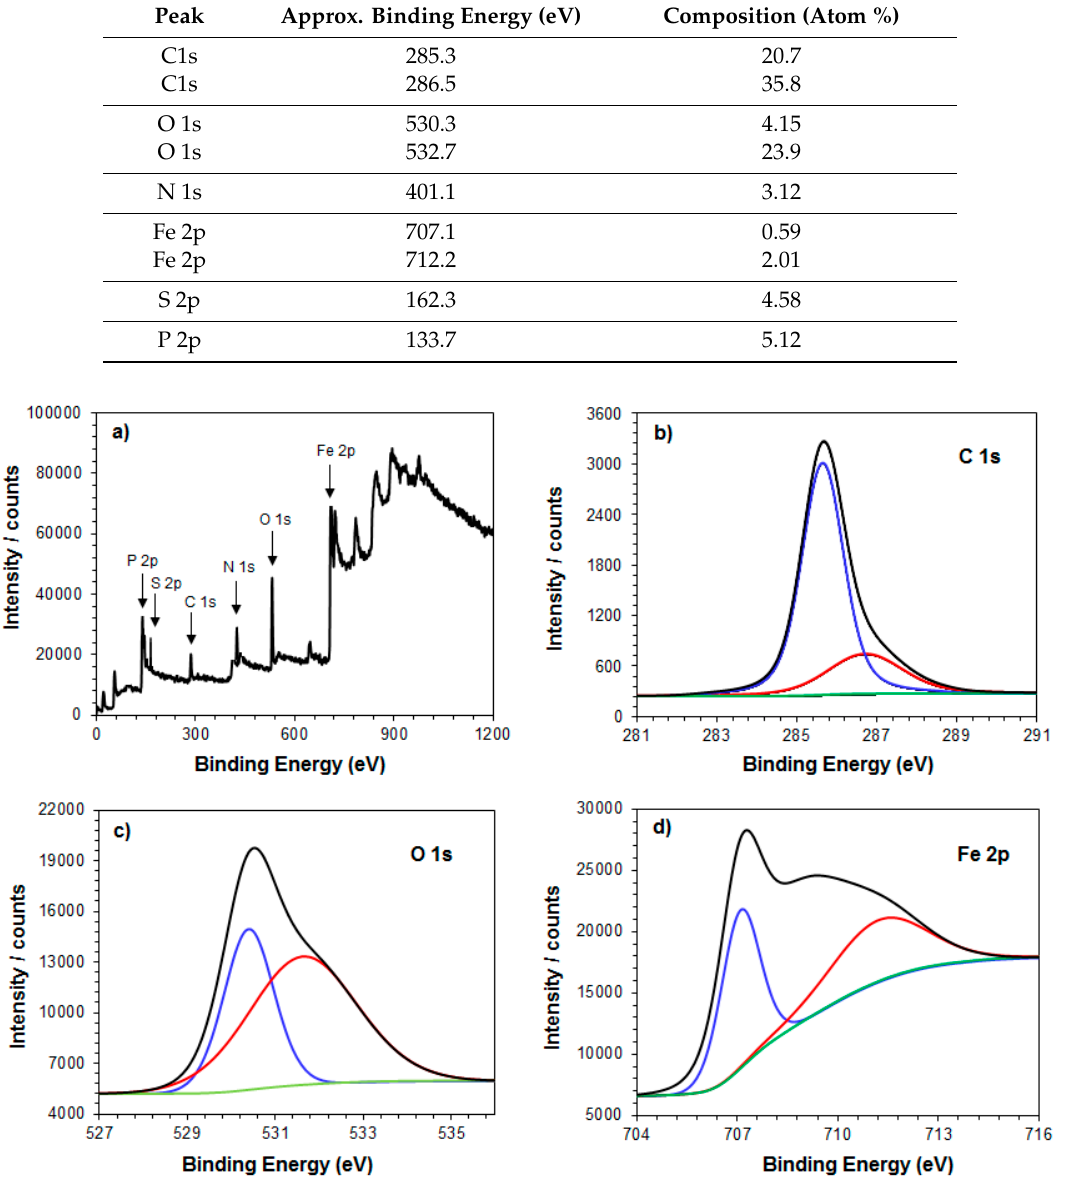
Figure 11. ( a ) Wide scan XPS spectra of Fe, and XPS deconvoluted spectra of ( b ) C 1s, ( c ) O 1s, and ( d ) Fe 2p in the presence of 4.50 × 10 − 4 mol L − 1 of corrosion inhibitor 7 after immersion of mild steel in 1